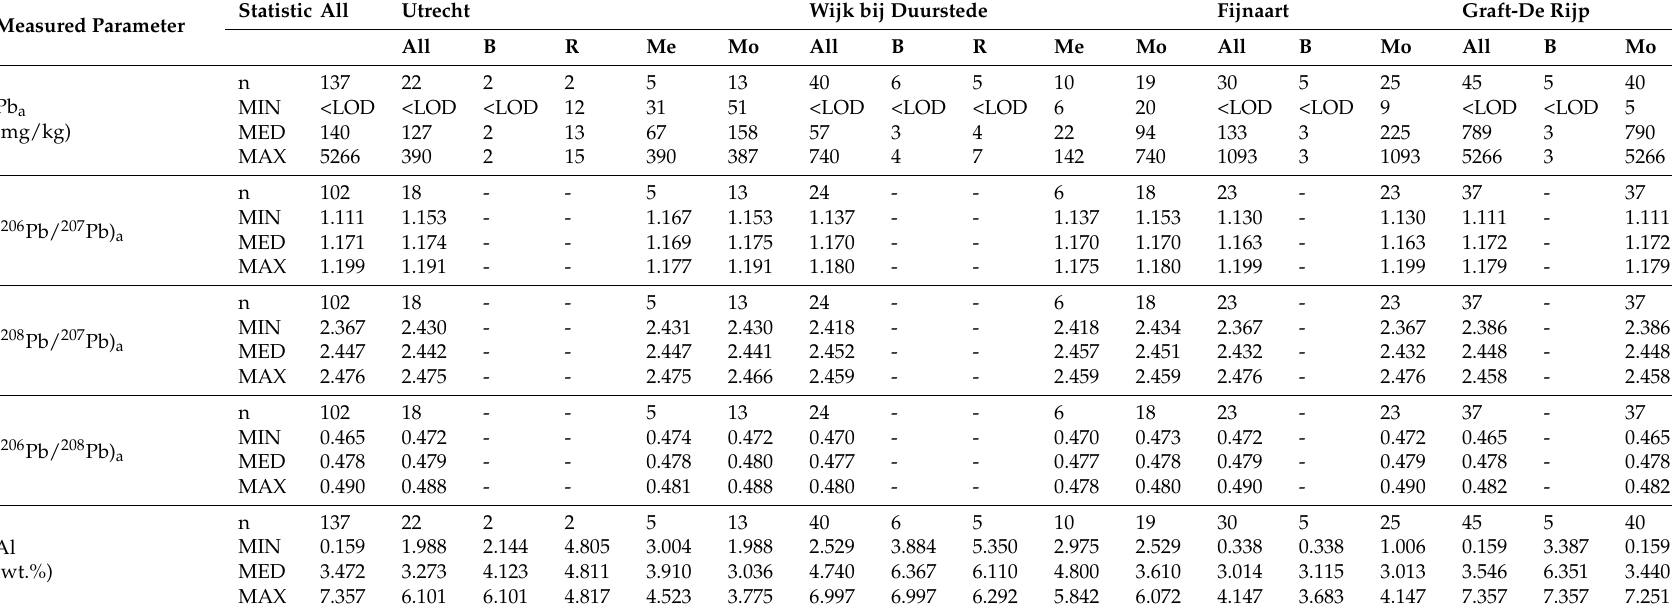
Table 2. Summary of the analytical and calculated results of the soils from Utrecht, Wijk bij Duurstede, Fijnaart and Graft-De Rijp. Measured